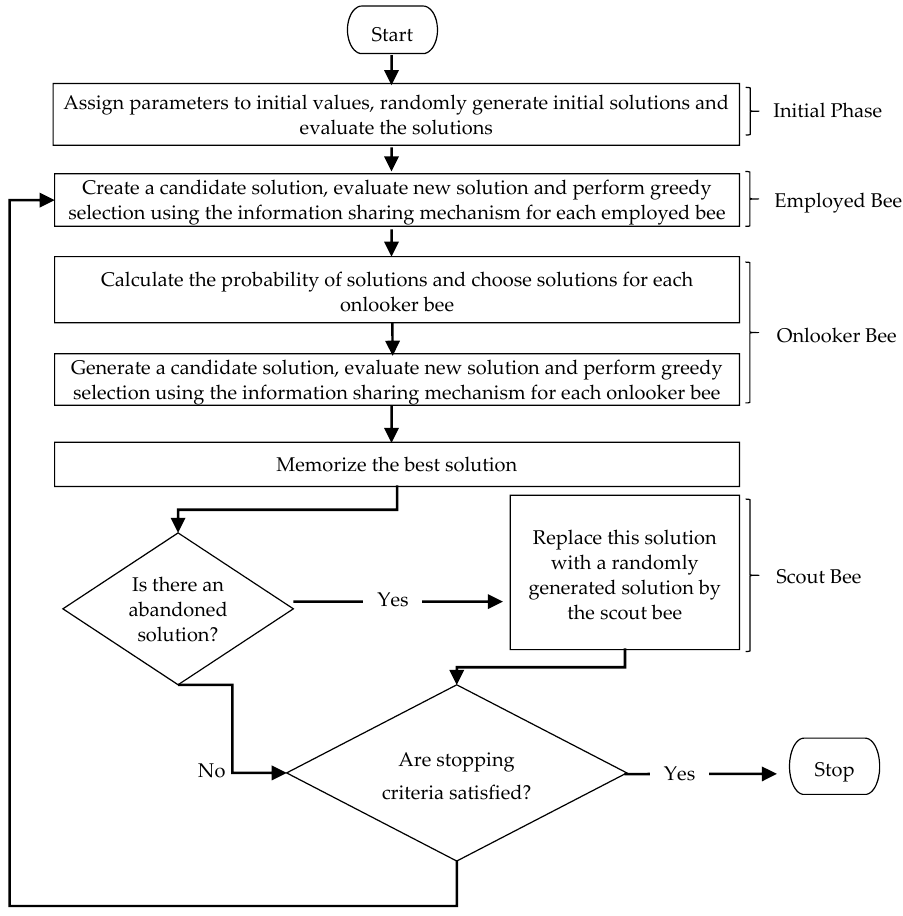
Figure 6. Flowchart ABCP algorithm.